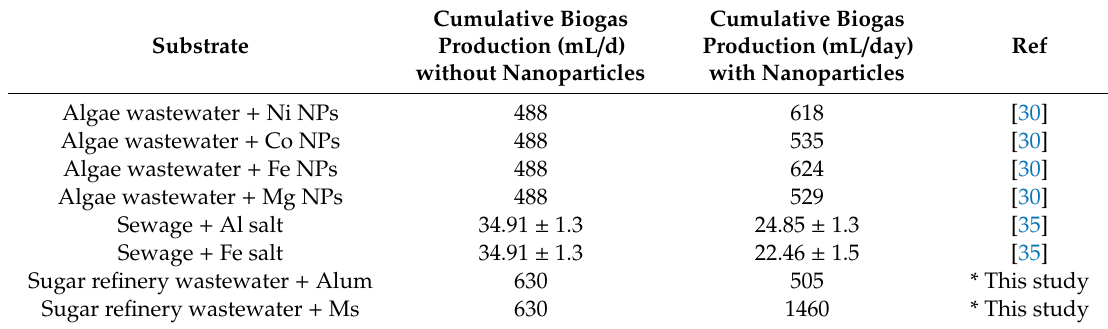
Table 5. Study on bio-catalytic e ff ect of Al- and Fe-based salts and nanoparticles on biogas production.